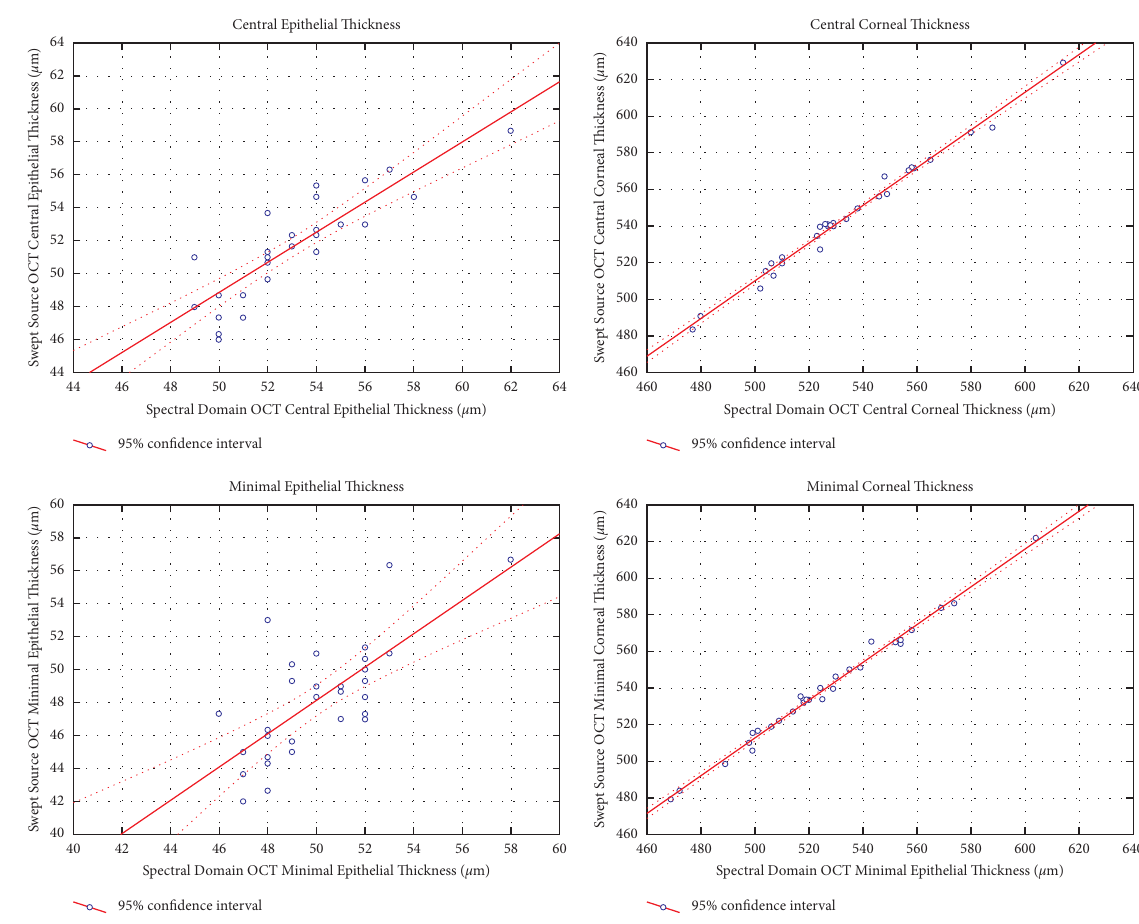
Figure 1: Correlation between Enhanced Spectral-Domain-OCTmeasurements and Spectral-Domain-OCTmeasurements of the epithelial and corneal thicknesses.